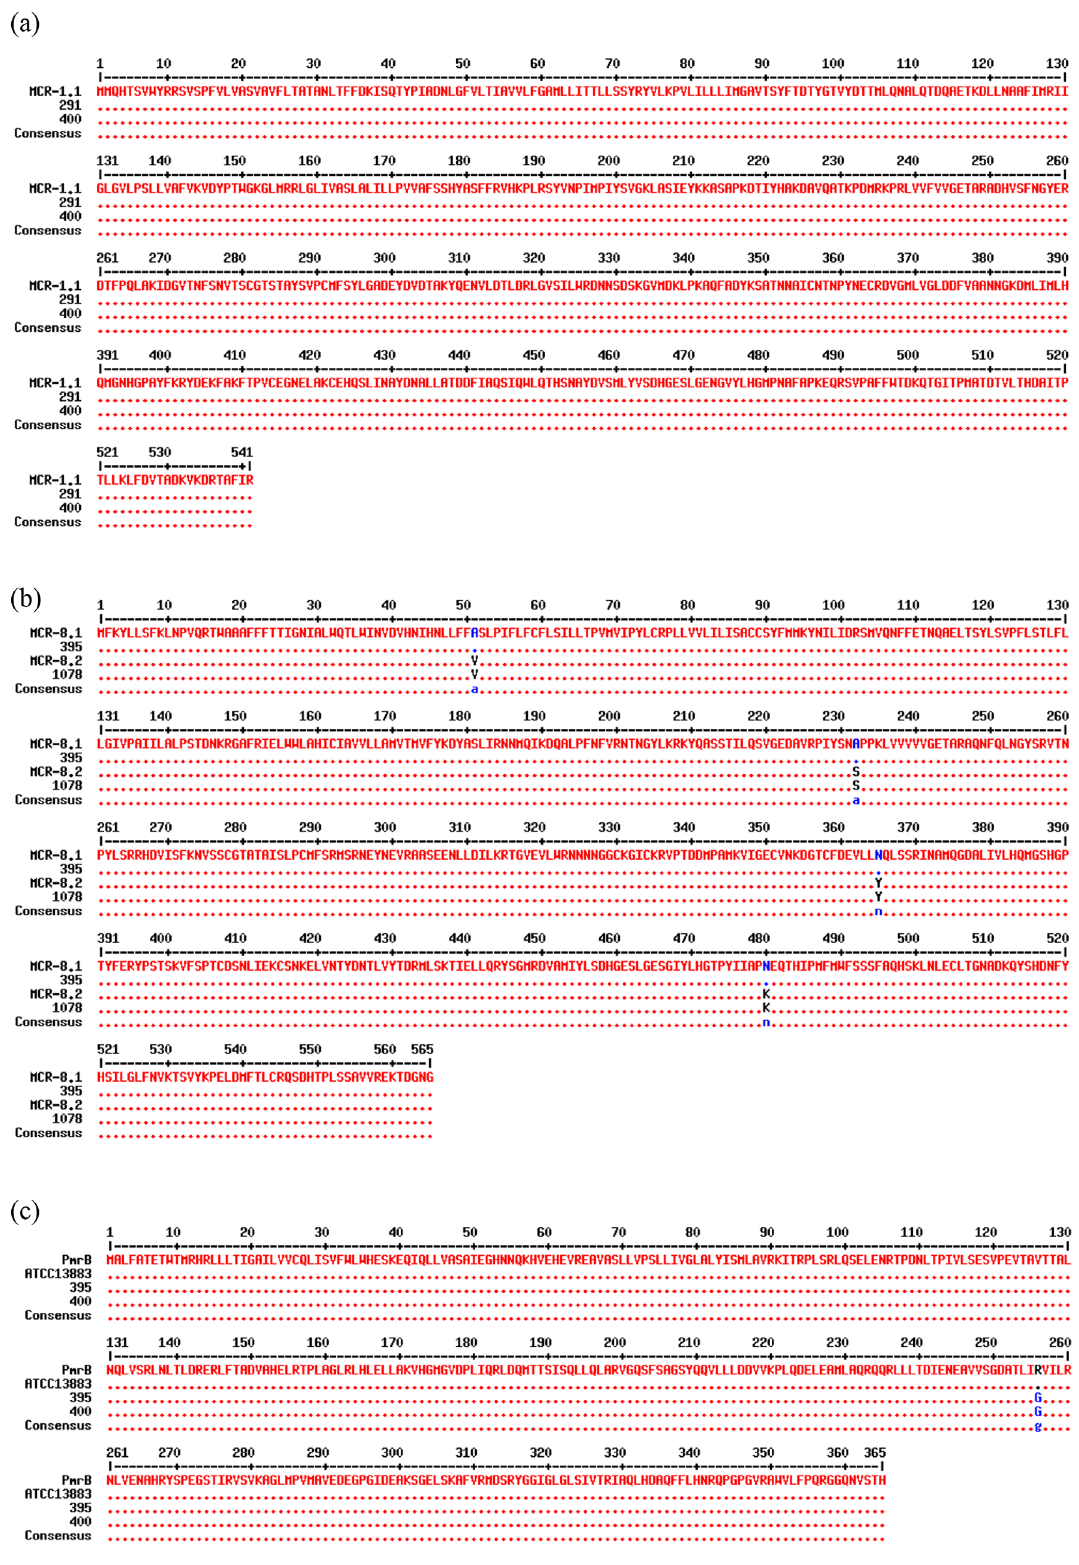
Figure 2. Plasmid-mediated colistin-resistant mechanisms ( a ) presence of Mcr-1.1 in ColRkp (n = 2), ( b ) presence of Mcr-8.1 and Mcr-8.2 in ColRkp (n = 1 each), ( c ) Combined presence of R256G PmrB in ColRkp (n = 2) found in this